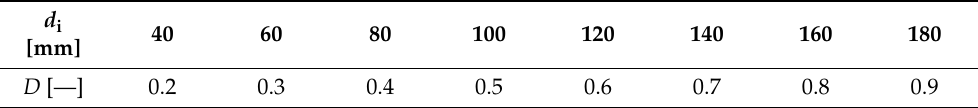
Table 1. Dimensions of the tested insert and the corresponding dimensionless